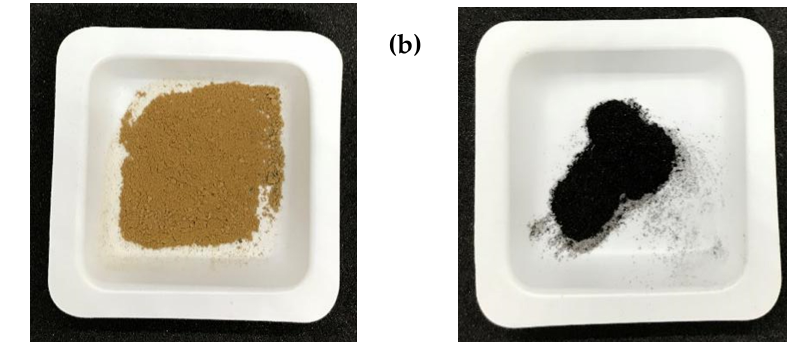
Figure 3. The fabricated powder of ( a ) GO and ( b ) rGO.